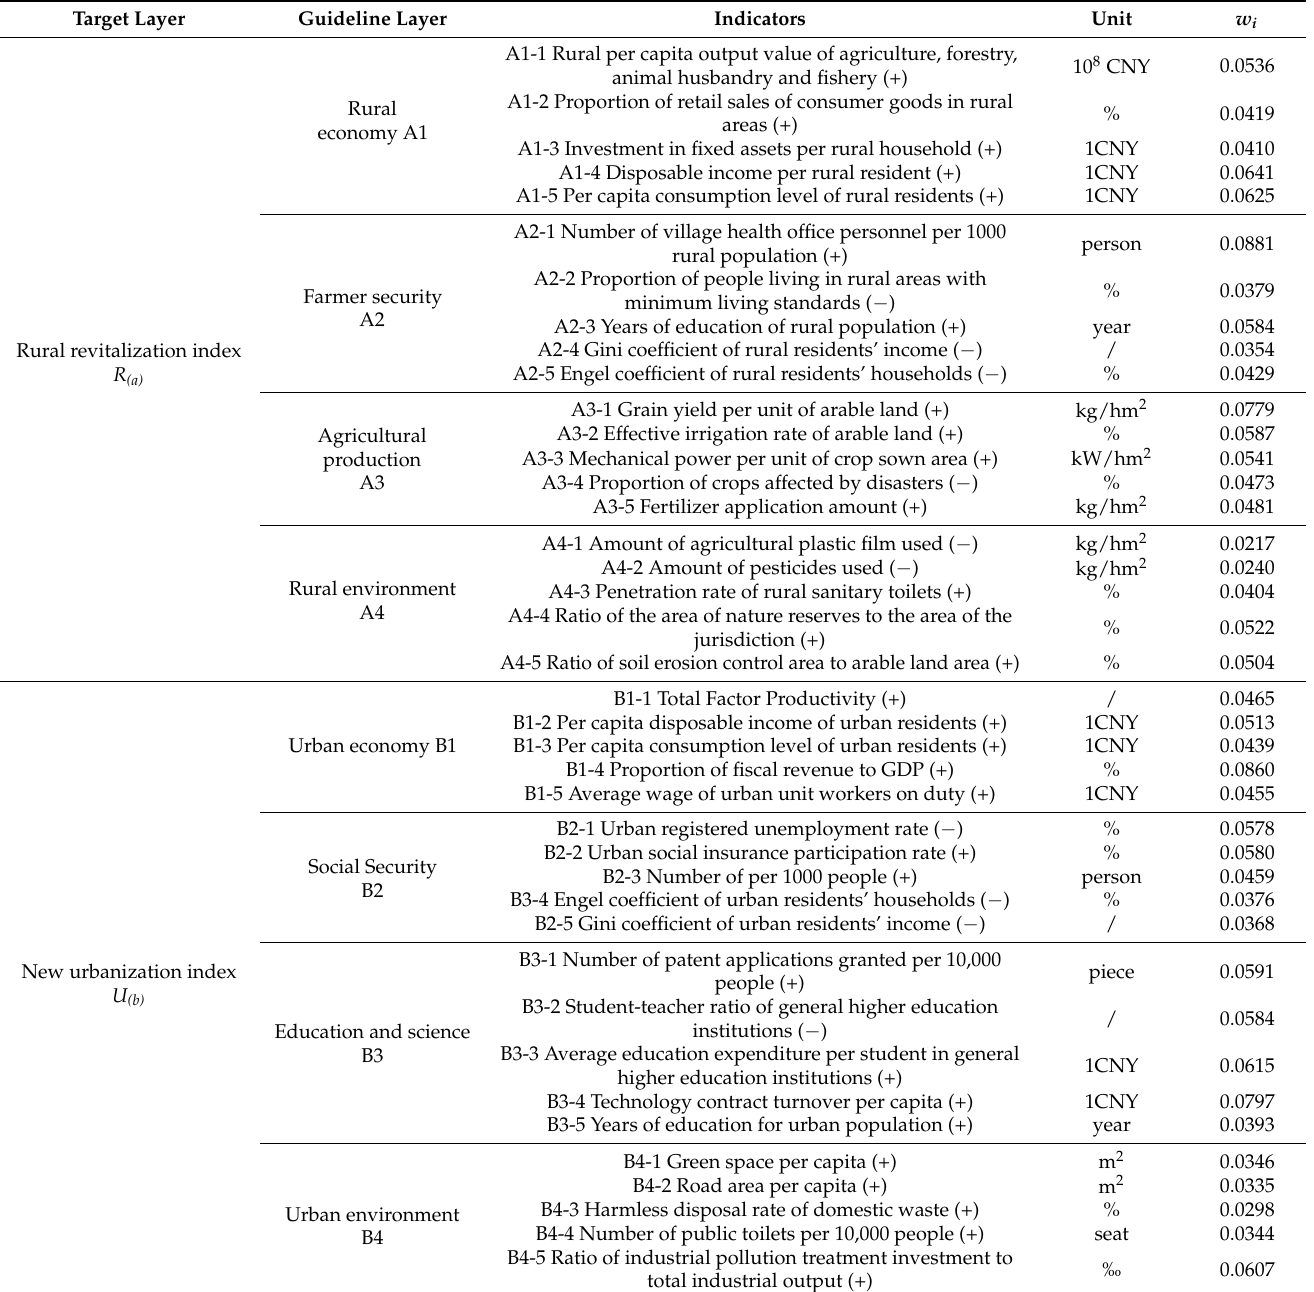
Table 1. Evaluation indicator system and composite weights of R (a) and U (b)